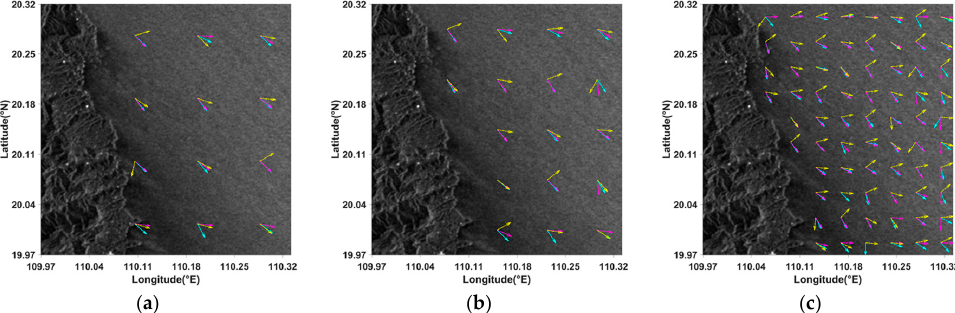
Figure 9. Wind directions retrieved by the three methods on different grids of the ASAR image acquired at 00:45, 25 March 2005 in VV polarization: ( a ) 7.5 km grid, ( b ) 6 km grid, ( c ) 3 km grid. Yellow, magenta and cyan arrows indicate wind directions retrieved by the FFT-like, LG-like and ILG methods, respectively.